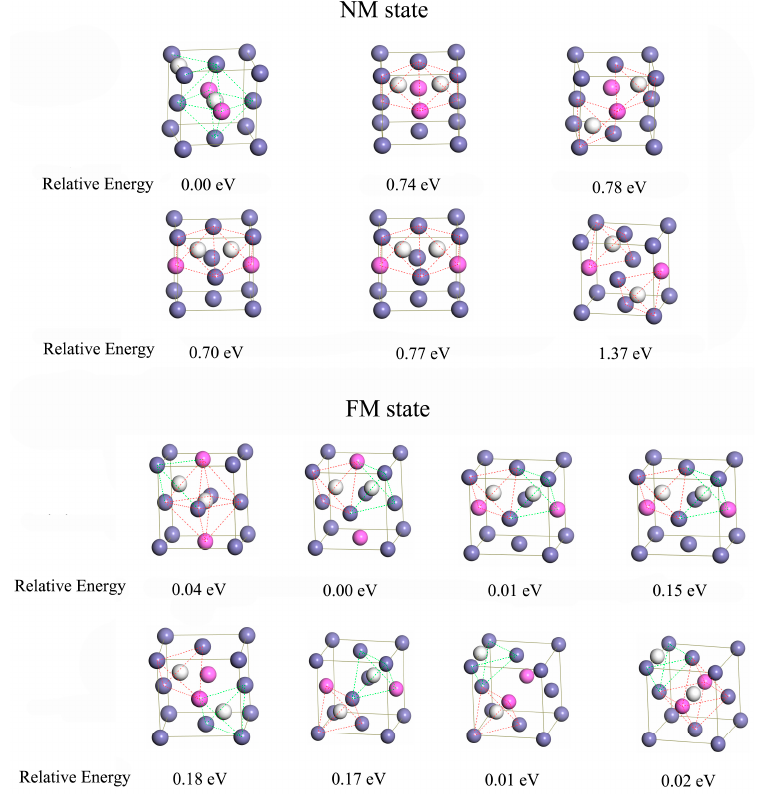
Figure A2. The structures of interstitial compounds of Al-containing austenite containing two hydrogen atoms and the relative energy (eV) in NM and FM states.